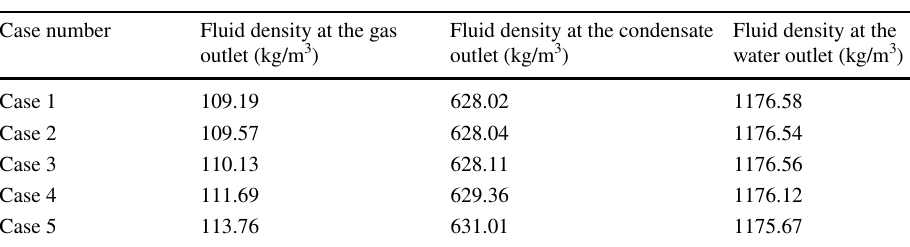
Table 7 Simulation results in terms of density